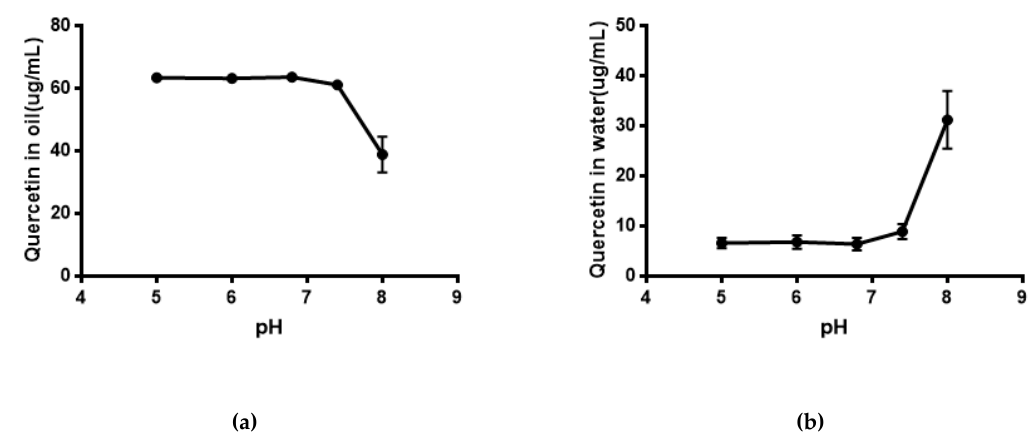
Figure 6. ( a ) Quercetin in oil; ( b ) Quercetin in water.